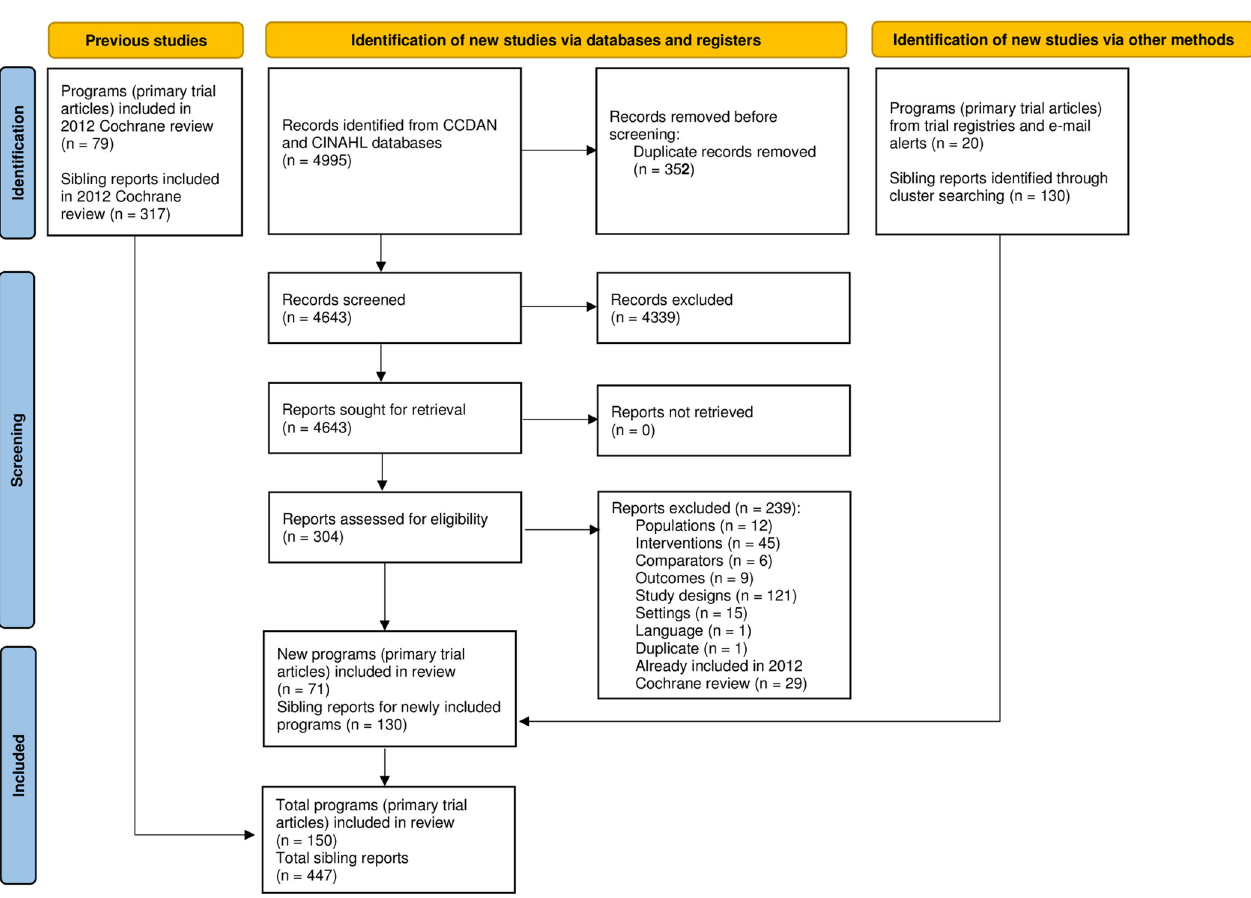
Fig 1. PRISMA flow